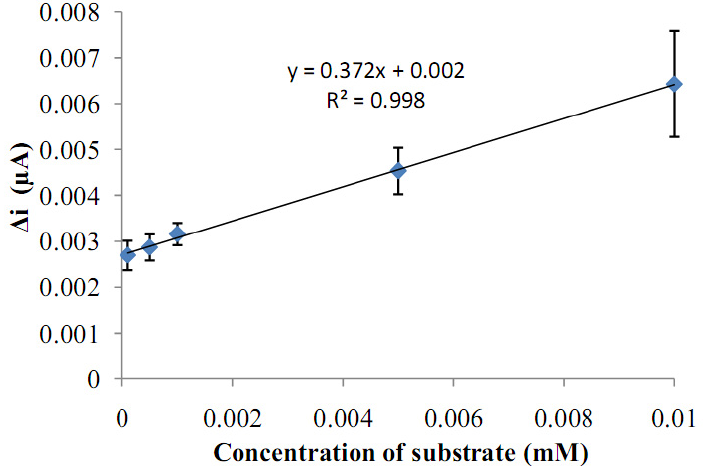
Figure 8. The calibration curve of the glucose biosensor (pH 7.5 phosphate buffer, 25 °C).